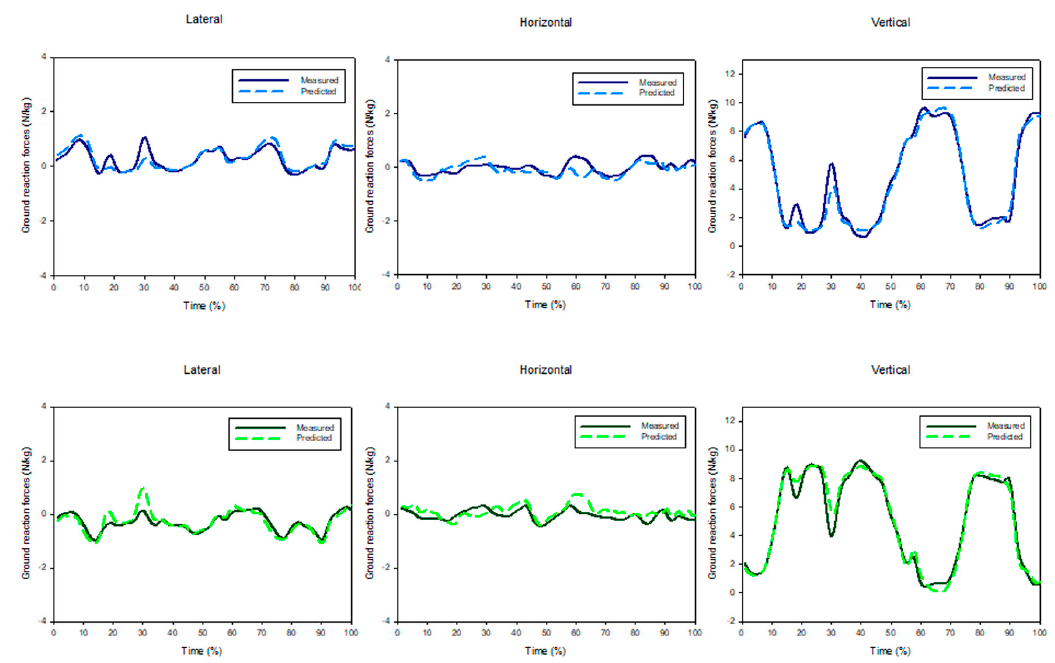
Figure 6. The measured and estimated GRF ( t ) s of a typical subject normalized by body mass (after [48]). A feed-forward ANN with one input layer, one hidden layer and one output layer was used to find tri-axial (cid:1833)(cid:1844)(cid:1832)((cid:1872)) and (cid:1833)(cid:1844)(cid:1839)((cid:1872)) signals during DSP. Data from 43 randomly selected subjects were used to train the ANN, and the remaining five were used for validation of the model. Out of 825 initial candidates, 14 input variables were selected for ANN using prior knowledge, the self- organising map technique and the genetic algorithm general regression neural network process. Cubic spline interpolation was used later to smoothly connect the results of SSP and DSP together. The (cid:1833)(cid:1844)(cid:1832)((cid:1872)) signals pertinent to each foot, predicted by their ANN model, showed a correlation coefficient and peak-to-peak normalised RMSE of 0.918% and 10.9% for (cid:1833)(cid:1844)(cid:1832) (cid:3040)(cid:3039) ((cid:1872)) , 0.985% and 7.3% for (cid:1833)(cid:1844)(cid:1832) (cid:3028)(cid:3043) ((cid:1872)) and 0.991% and 5.8% for (cid:1833)(cid:1844)(cid:1832) (cid:3049) ((cid:1872)) , respectively (Figure 7). In addition, the correlation coefficients of 0.987 in the sagittal plane, 0.841 in the frontal plane, and 0.868 in the transverse plane were found for (cid:1833)(cid:1844)(cid:1839)((cid:1872)) signals. Oh, et al., then compared the results of their ANN model with the